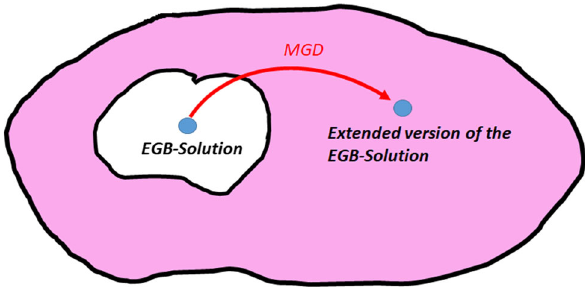
Fig. 1 Schematic picture of a Minimal Geometric Deformation (MGD) approach